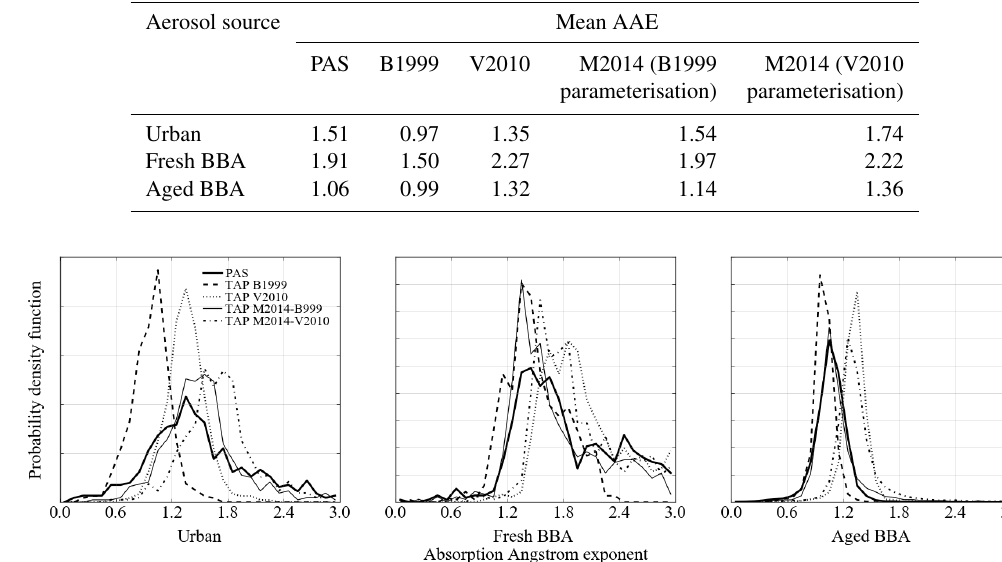
Figure 8. Probability density functions of the absorption Ångström exponents derived for PAS and TAP measurements using the range of TAP correction schemes as outlined in Sect. 2.1.1–2.1.3. All absorption coefficients correspond to >1Mm − 1